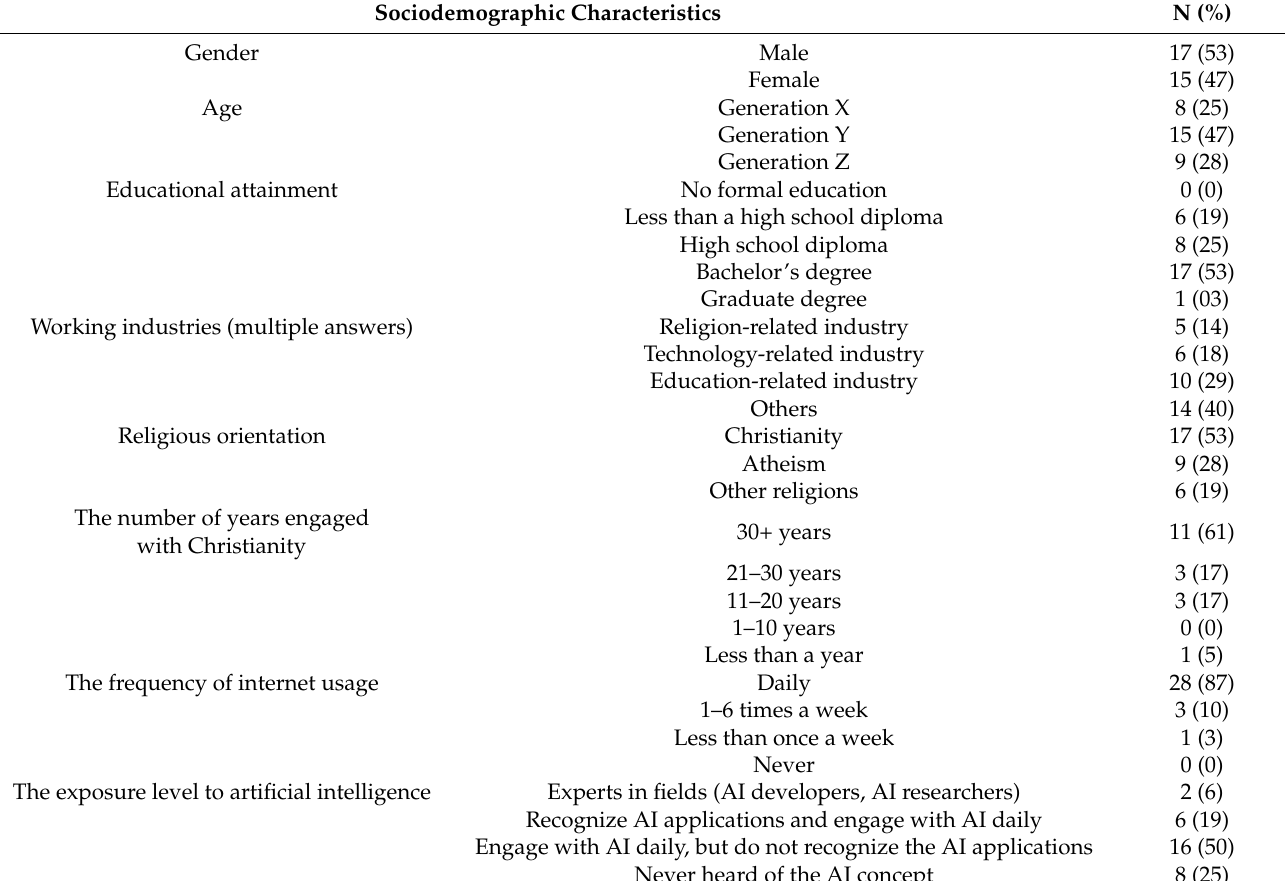
Table 1. Key sociodemographic